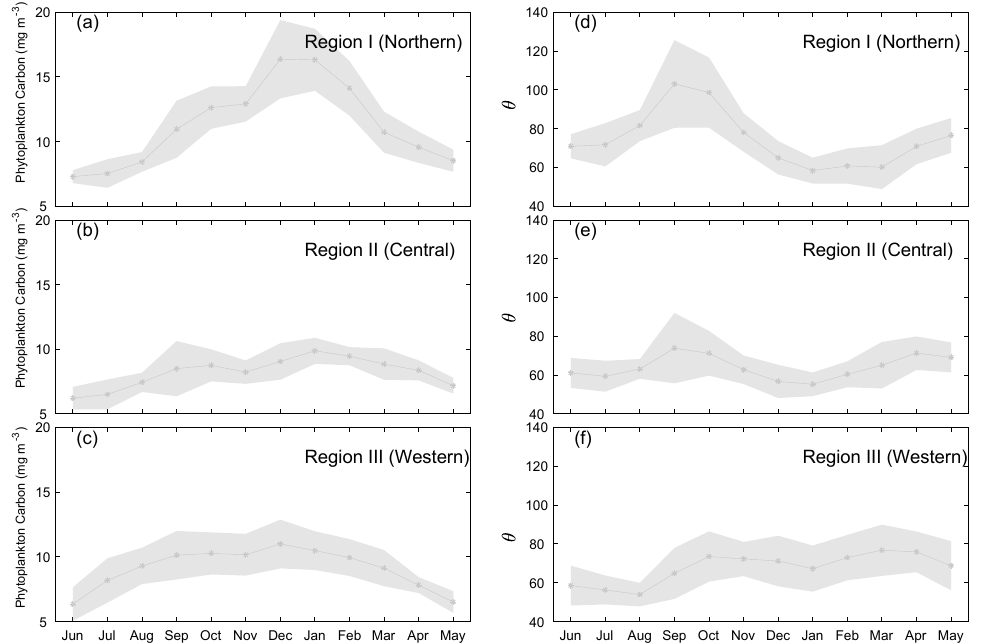
Figure 7. Time-series of monthly mean climatology of phytoplankton carbon ( a – c ) and θ ( d – f ) in the northern (Region I), central (Region II), and western (Region III) parts of South China Sea. The definitions of those regions are shown in Figure 3a. Color shading indicates standard deviations of the monthly mean climatology of θ . Noting that the time starts in June. The monthly averaged climatology of θ —computed over the SCS using composite monthly images from September 1997 to December 2019—varied over a wide range